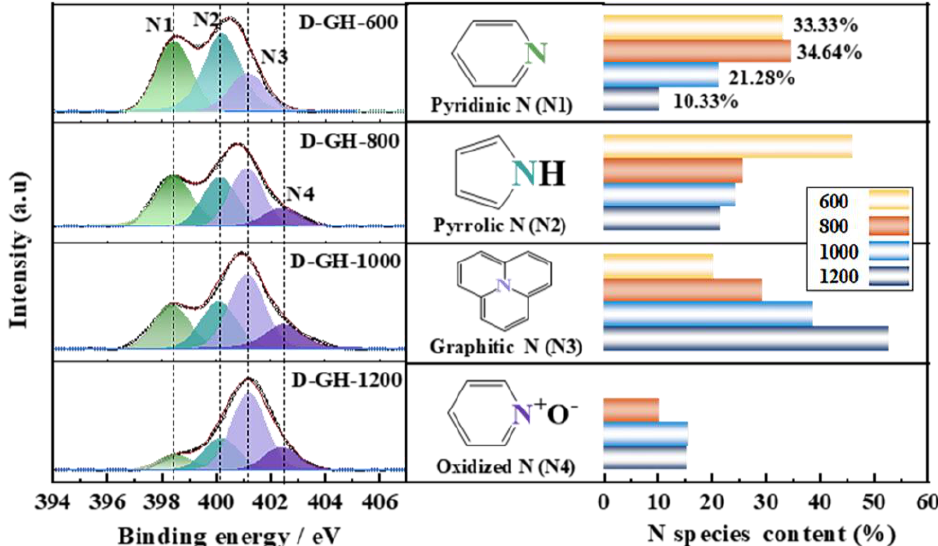
Figure 3. N 1s XPS spectra of D-GH-T and the pyridinic-N, pyrrolic-N, graphitic-N, and oxidized N content on N 1s XPS spectra.